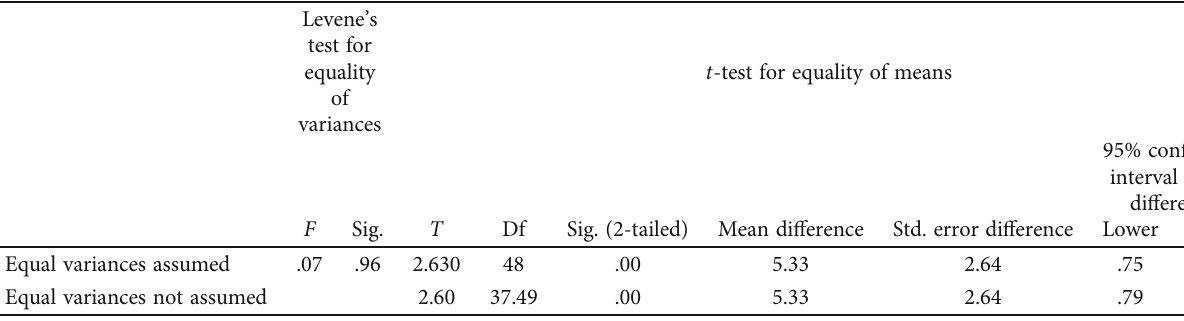
Table 5: Inferential statistics of the two groups in the speaking posttests.